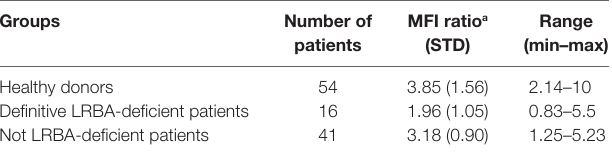
tABLe 2 | Mean fluorescence intensity (MFI) in healthy donors and patients suspected of LRBA deficiency.